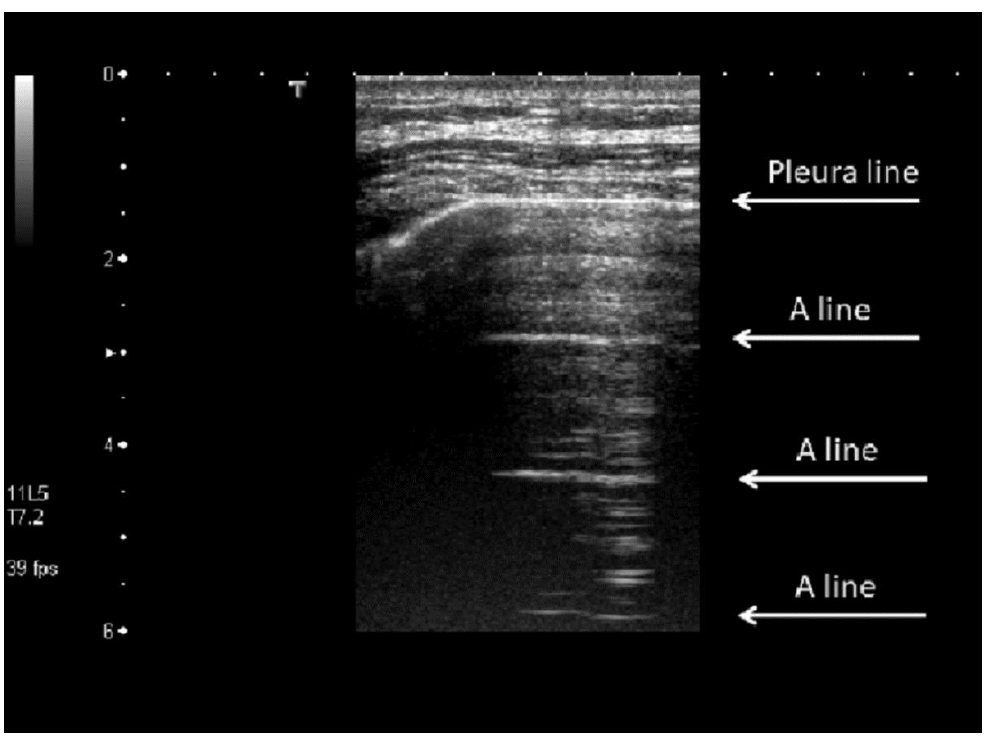
Figure 1. A-lines in a healthy lung. The top image presents a thoracic wall layer (skin, fat and muscles) that ends with the hyperechoic pleural line. Hyperechoic horizontal lines called A-lines, produced by the wave reverberations, are shown beneath. Reprinted/adapted with permission from [10]. 2022, Acoustical Society of America.